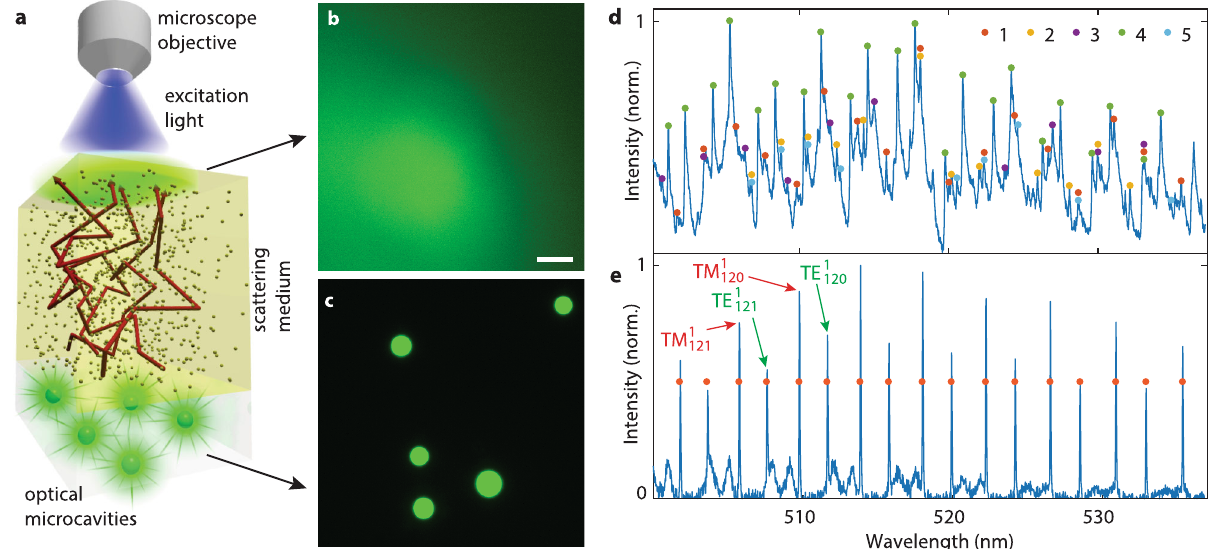
Fig. 1 Spectral reconstruction of microcavities beneath a scattering medium. a Schematics of the experimental con fi guration and light propagation. b Fluorescence image of the microcavities taken through a 170 μ m thick strongly scattering layer. Scale bar, 20 μ m. c Fluorescence microscope image of the same area without the scattering layer. d Spectra taken from the whole area in b with the fl uorescence background removed. The spectral peaks belonging to a particular microcavity are grouped together. Some peaks are associated with more than one microcavity. e Comparison of the spectrum from one particular microcavity without the phantom (blue line) and the reconstructed peak positions